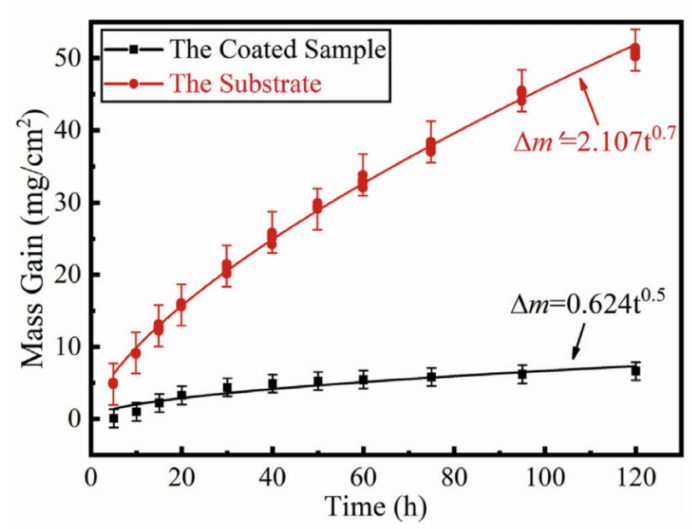
Figure 5. The oxidation kinetic curves (mass gain versus time) of the Ti-Al-Si coating and the substrate of Ti-6Al-4V alloy at 800 ◦ C in air. Reprinted from Journal of Alloys and Compounds, 830, Xiaoyuan Hu, Faguo Li, Dongming Shi, Yu Xie, Zhi Li, Fucheng Yin, A design of self-generated Ti–Al–Si gradient coatings on Ti–6Al–4V alloy based on silicon concentration gradient, 154670, Copyright (2020), with permission from Elsevier